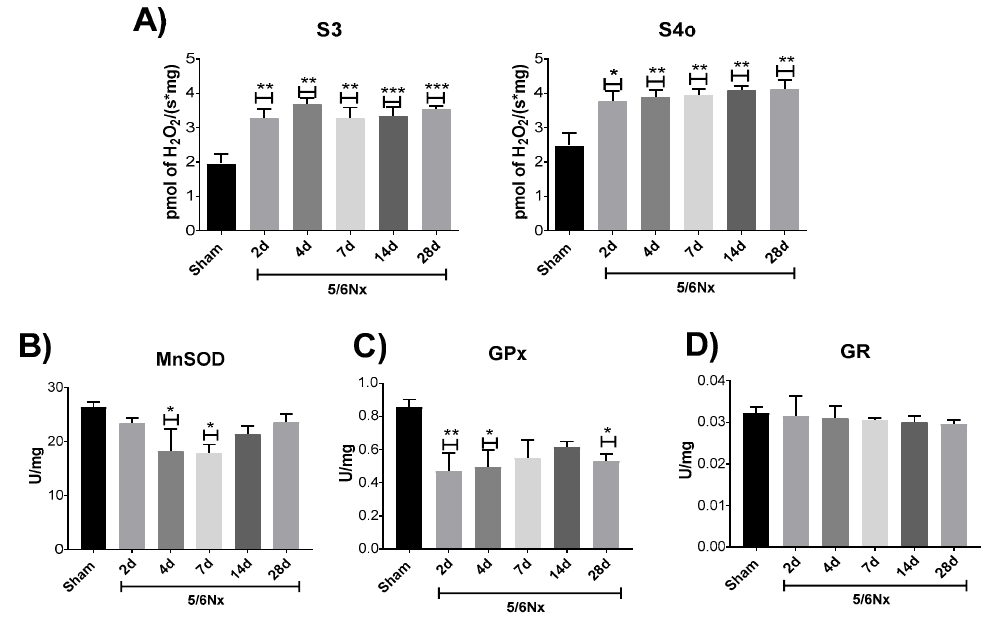
Figure 6. Oxidative stress in mitochondria of the remaining renal mass. ( A ) Hydrogen peroxide (H 2 O 2 ) production rates in isolated mitochondria in state 3 (S3) and state 4 induced by oligomycin (S4o). ( B ) Activity of the antioxidant enzymes Mn superoxide dismutase (MnSOD), glutathione peroxidase (GPx), and glutathione reductase (GR) in isolated mitochondria. Data are mean ± SEM, n = 5–6. * p < 0.05, ** p < 0.01, and *** p < 0.001 vs. Sham. d = days after nephrectomy surgery, Sham = simulated operation-control group; 5/6Nx= 5/6 nephrectomy.